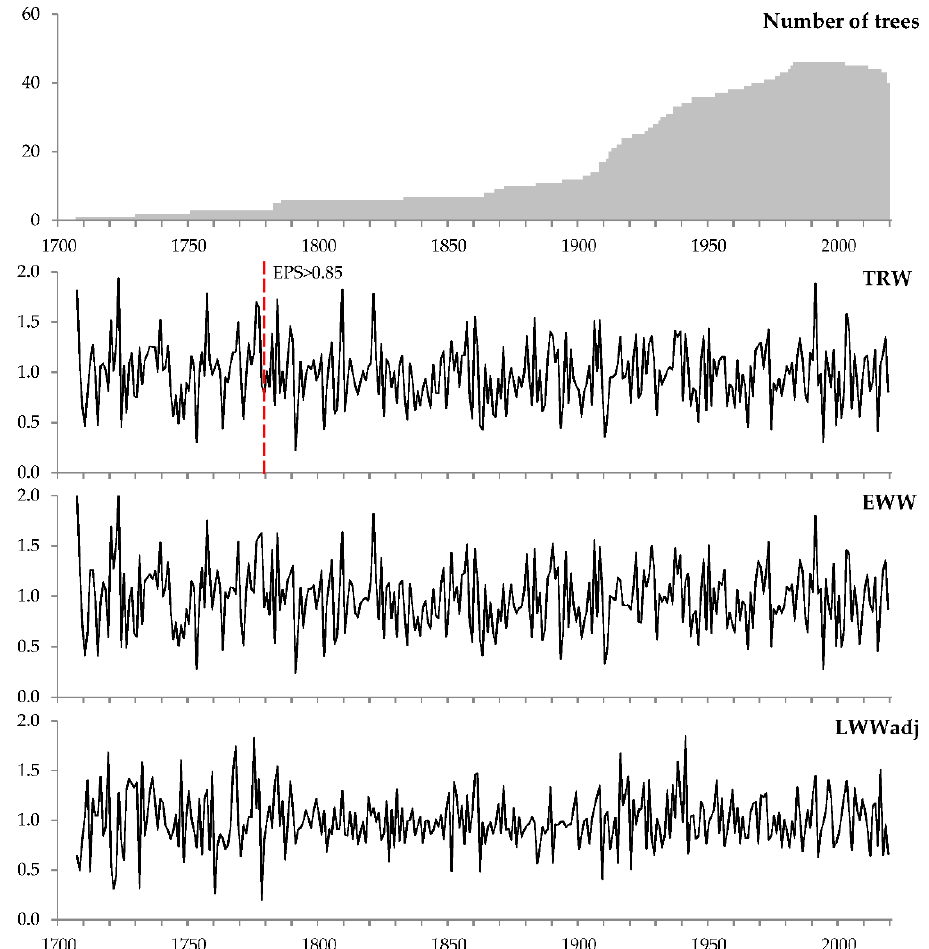
Figure 2. Residual generalized chronologies of larch tree-ring width (TRW), earlywood width (EWW), and latewood width adjusted (LWW adj ). Upper plot shows number of trees (individual series) for each year. On the TRW plot, vertical dashed line marks beginning of period with expressed population signal above threshold EPS > 0.85.